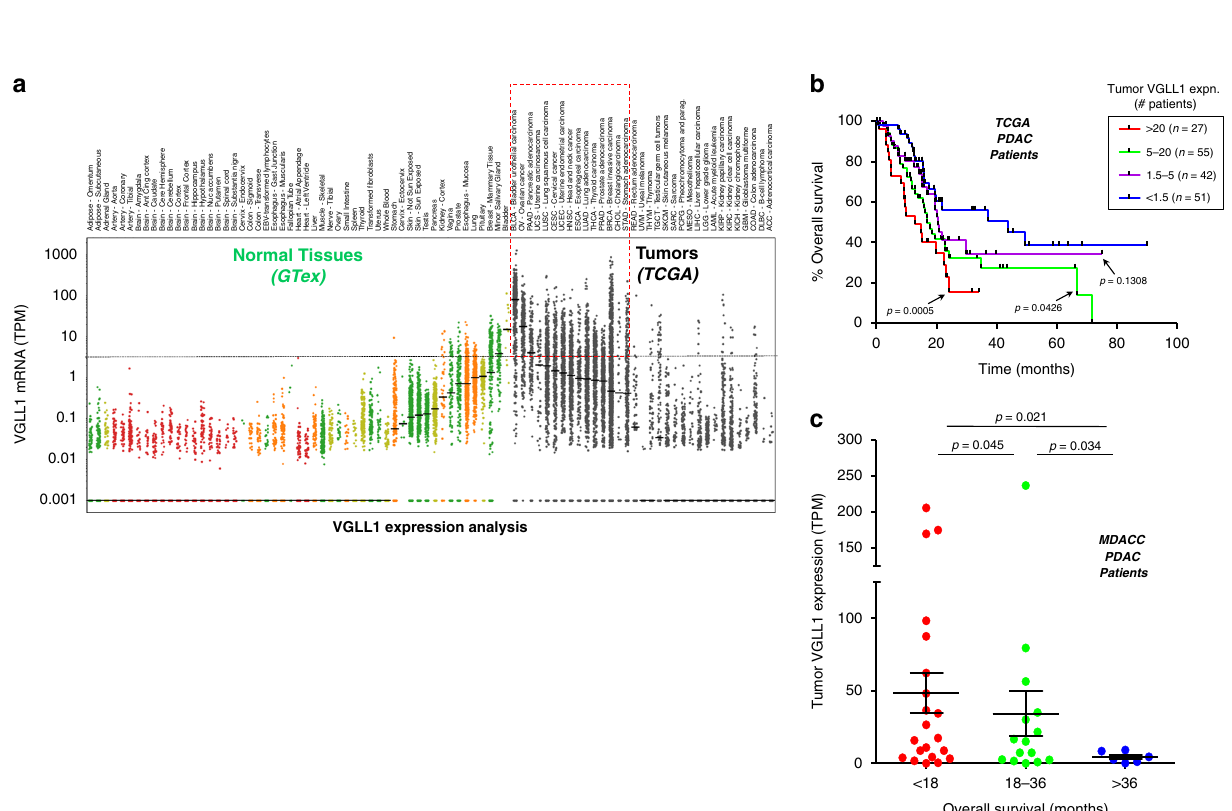
Fig. 2 VGLL1 is overexpressed in multiple tumor types and is associated with poor pancreatic patient survival. a VGLL1 transcript expression in normal tissues (colored dots, GTex Portal database) and human cancers (black dots, TCGA database), as determined by RNAseq analyses. Each dot represents one normal donor or patient tumor sample. Colors correspond to the four normal tissue categories de fi ned in Fig. 1: Green, non-essential tissues; yellow, caution tissues; orange, hazard tissues; red, danger tissues. While >95% of normal GTex caution, hazard, and danger tissue samples fell below 3 transcripts per million (TPM, dotted line), signi fi cant numbers of TCGA cancer patients demonstrated VGLL1 transcript expression above this threshold (red box). b Kaplan – Meier curves showing TCGA PDAC patient overall survival (OS) strati fi ed by tumor VGLL1 transcript expression ( n = 178). P -values indicate log- rank signi fi cance test results comparing the OS of three groups of VGLL1-expressing patients to those patients with low or absent VGLL1 expression using Gehan – Breslow – Wilcoxon test. c Patient-derived xenografts (PDX) from an independent cohort of MD Anderson metastatic PDAC patient tumors ( n = 42) underwent RNAseq analysis after being grown in immunode fi cient mice. Graph shows PDX specimens strati fi ed into three groups corresponding to OS time and corresponding VGLL1 transcript expression. Data are presented as mean values + / − standard deviation. P -values indicate log-rank signi fi cance test results comparing each group using an ANOVA test. Adjustments were made for multiple